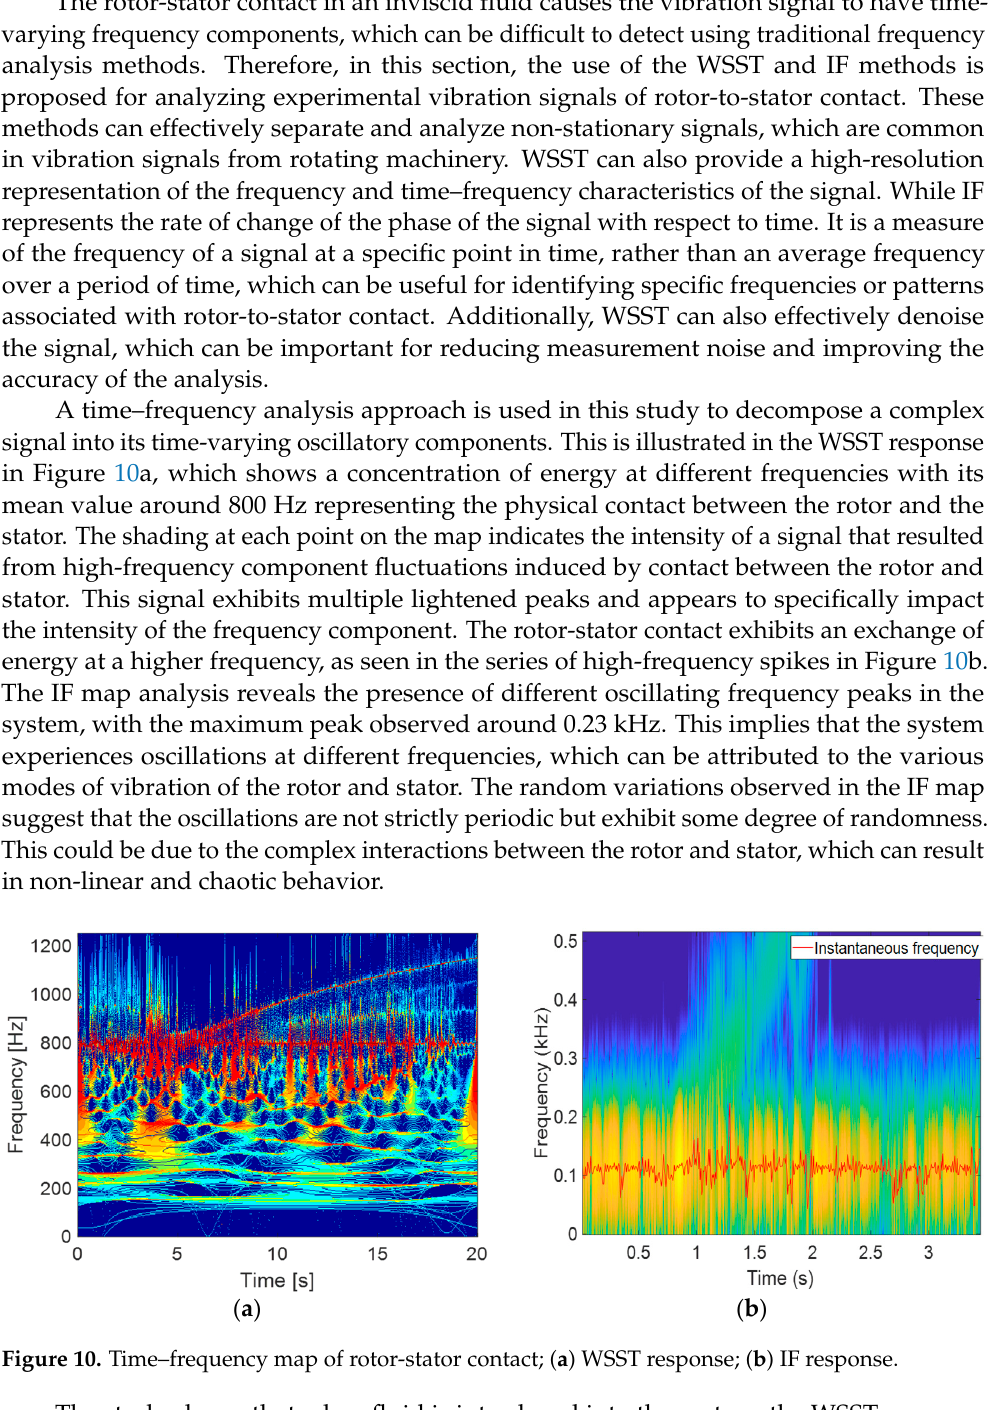
( b ) Figure 11. Time-frequency map of rotor-stator contact in fl uid; ( a ) WSST response; ( b ) IF response. The result of the study indicates that there is evidence of both super and sub- harmonic behavior in the distributed energy when analyzing the fast Fourier transform (FFT) of a set of points in Figure 12a. The presence of super and sub-harmonic behavior suggests that there is a prominent rotor-stator contact in the spectrum of the signals. The rotor and stator coming into contact at various frequencies may lead to mechanical wear and tear of the components, which can lead to further problems in the system. The energy generated by this contact is distributed across a range of frequencies, with a maximum amplitude of 0.014 FFT. This amplitude indicates the strength of the signal at the corresponding frequency. Figure 12b shows that the harmonic components of the signal are periodically distributed with shape disturbance and low, irregular energy distribution peaks with 0.06 FFT amplitude. This re fl ects the impact of fl uid properties on a smaller scale of continuous contact throughout the signal spectrum. This suggests that the fl uid